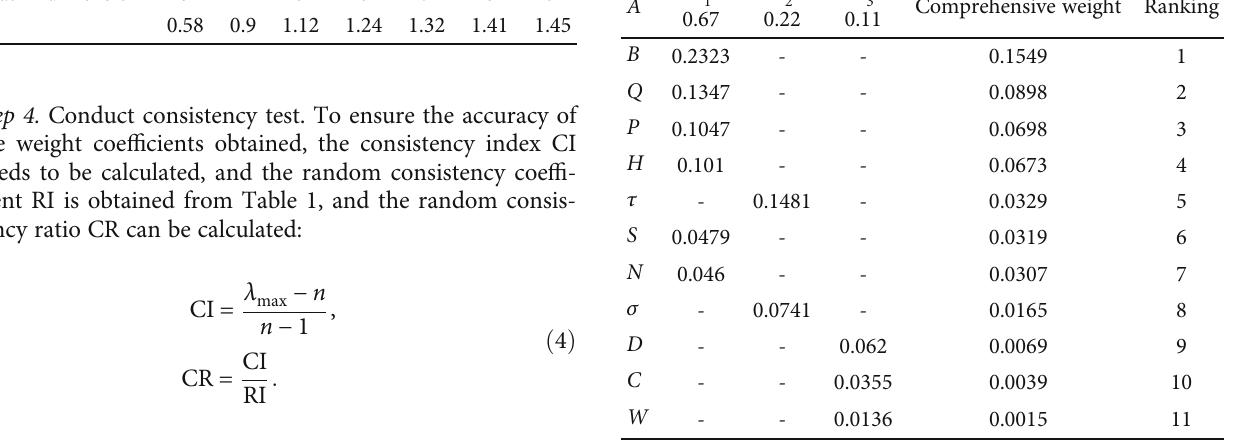
Table 1: Random consistency coe ffi cient. Matrix dimension